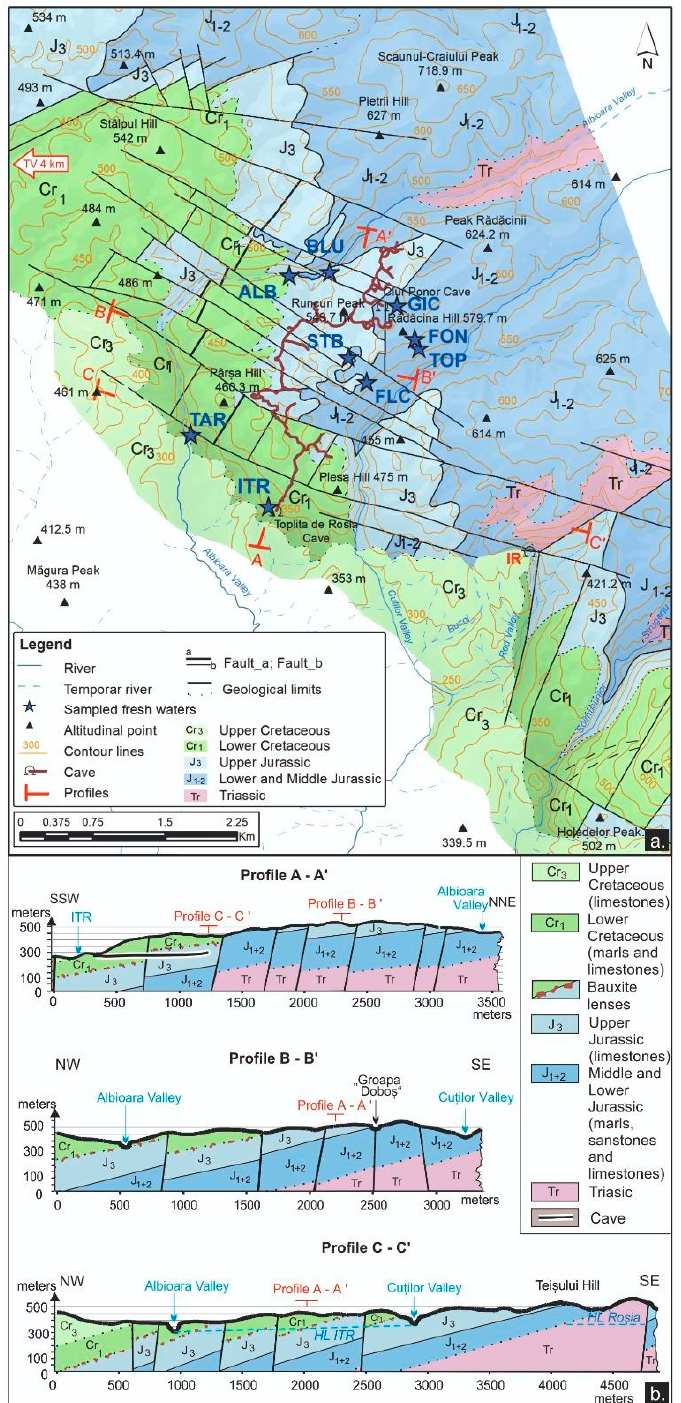
Figure 2. KSRP and the adjacent area geology (original work): ( a ) geological map with location of sites; ( b ) geological profiles from the studied area. The three-letter acronyms correspond to the sampled freshwater sources (see Table 1).